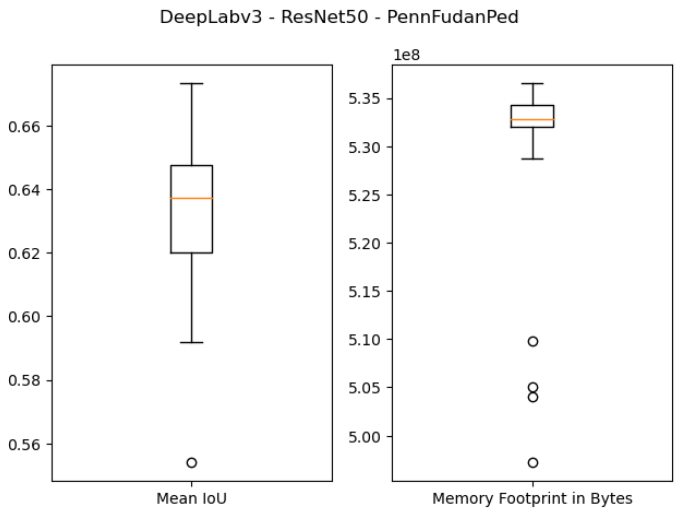
Figure 12. Boxplot results for the Penn–Fudan dataset using the ResNet50 backbone and 512 MB of desired memory